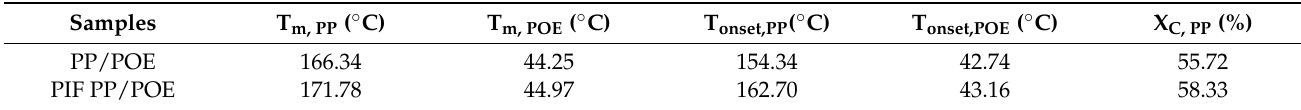
Table 3. Thermal properties of PP/POE blends before and after PIF